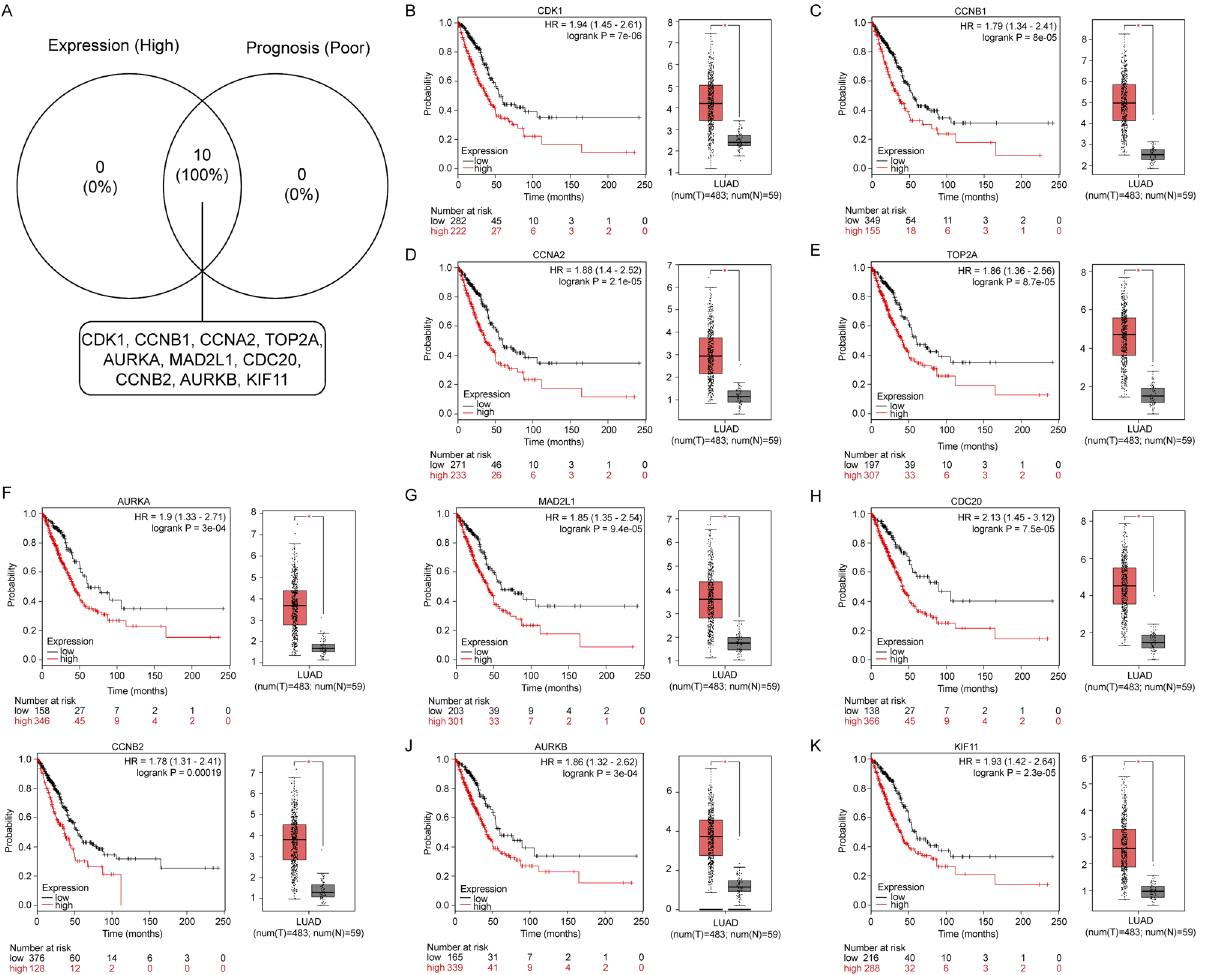
Figure 3. Screening the key upregulated genes in LUAD. ( A ) Identification of the key genes with high expression and poor prognosis values among significantly upregulated hub genes. ( B – K ) Representative expression and prognostic value of hub genes validated with Gene Expression Profiling Interactive Analysis (GEPIA) and Kaplan–Meier plotter databases,